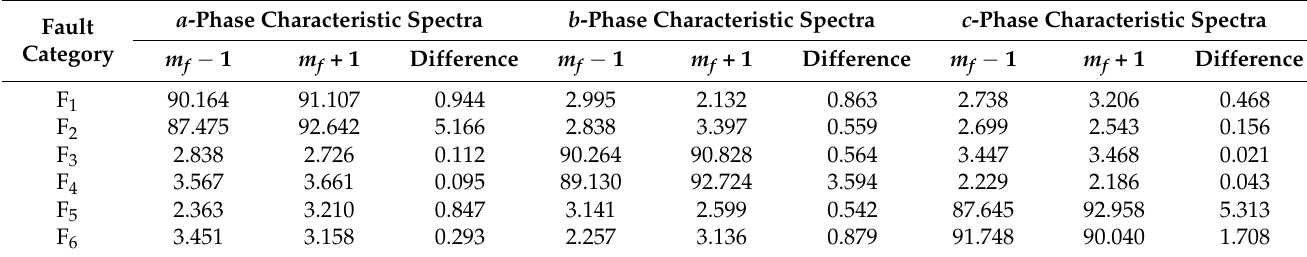
Table 4. Characteristic spectral data of the inverter at 120 Hz with different fault